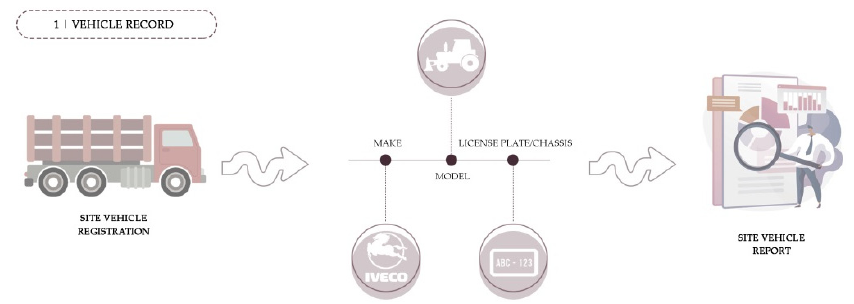
Figure 11. Vehicle control framework—Model Smart Management.